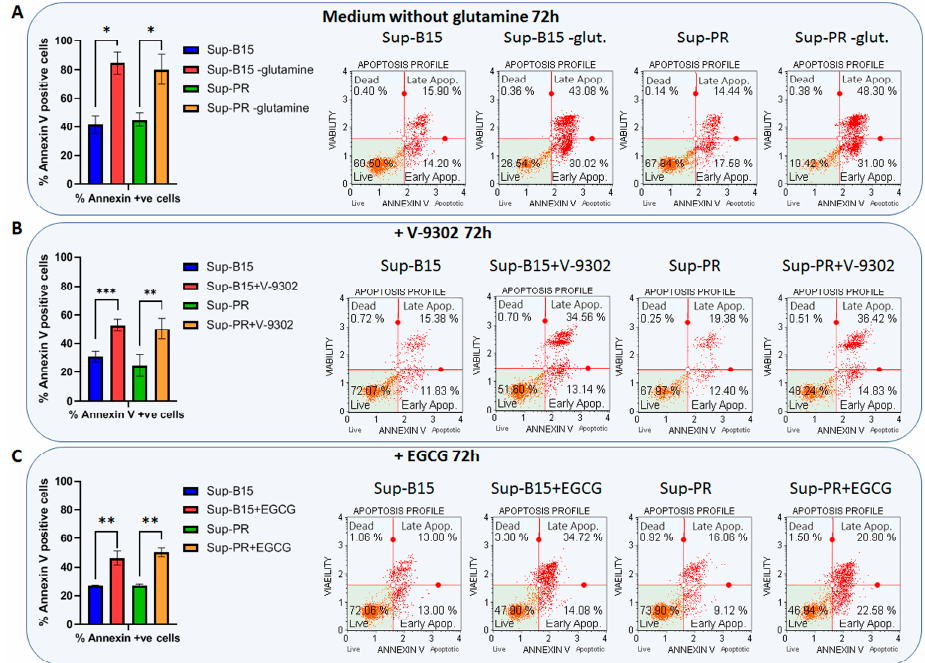
Figure 3. Targeting glutamine metabolism induces apoptosis in cALL cell lines. The percentage of live and annexin-positive cells, and representative flow cytometry plots, of Sup-B15 and Sup-PR cells grown for 72 h in a medium without Gln (top panel), or treated with IC50 concentrations of the Gln transporter inhibitor V-9302 (middle panel) and with the glutamate dehydrogenease inhibitor EGCG (bottom panel). Error bars represent the mean with SD from biological duplicates. *— p < 0.05, **— p < 0.005, ***— p < 0.0005, Student’s t -test.